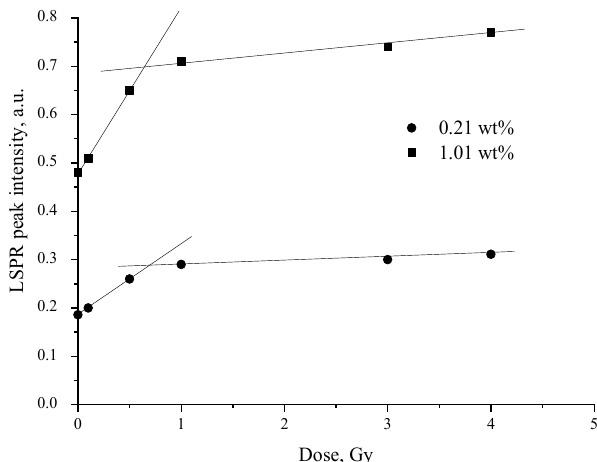
Figure 6. LSPR peak intensity variations with the irradiation dose in AgPVAF films containing different concentrations of AgNO 3 .